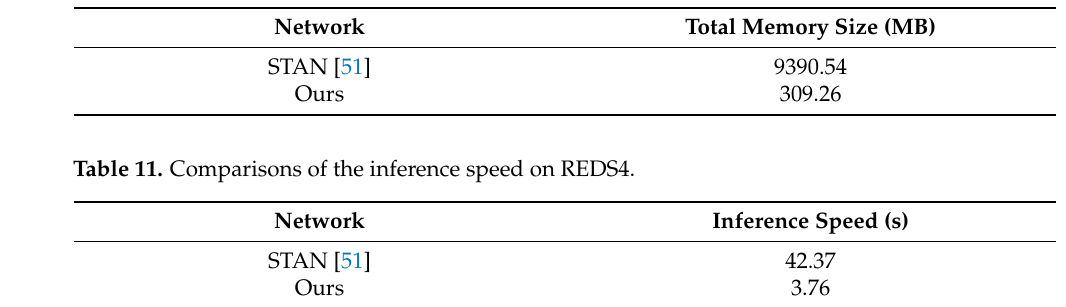
Table 10. Comparisons of the total memory size.